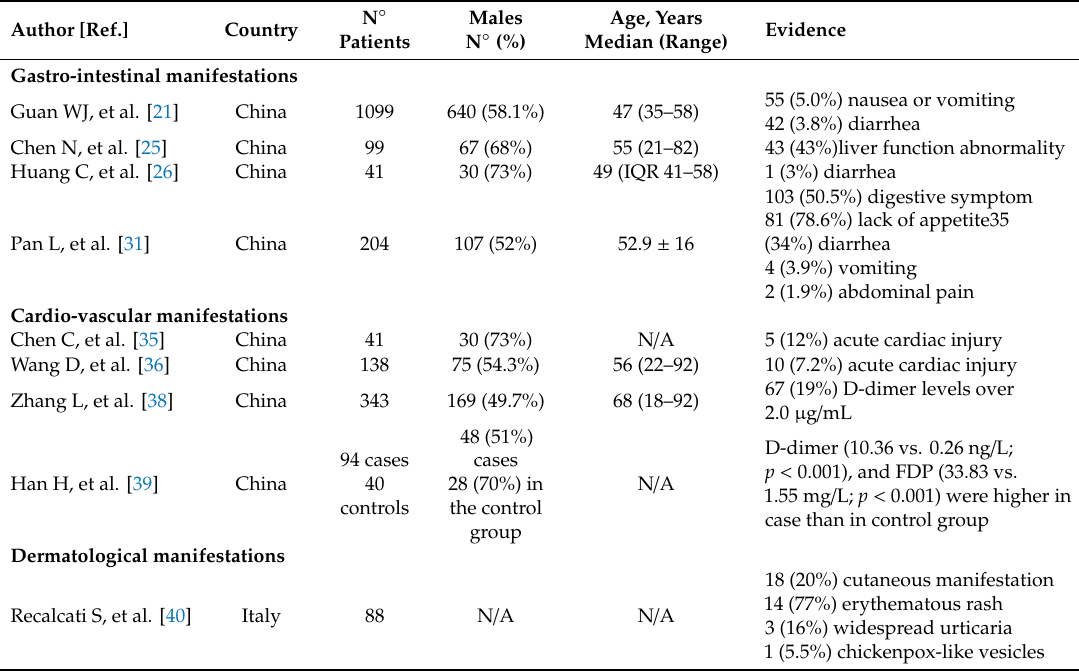
Table 2. Studies reporting the atypical clinical presentation of